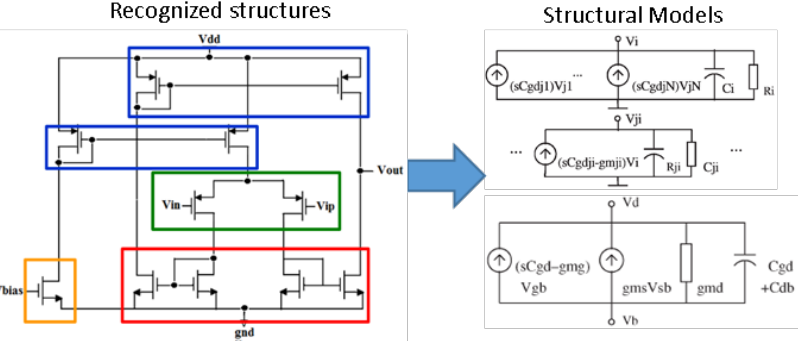
Figure 3. Illustration of macromodeling on building blocks.